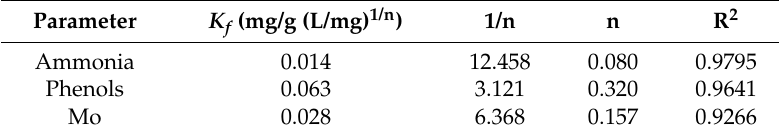
Table 6. Freundlich equation for ammonia, phenols, and